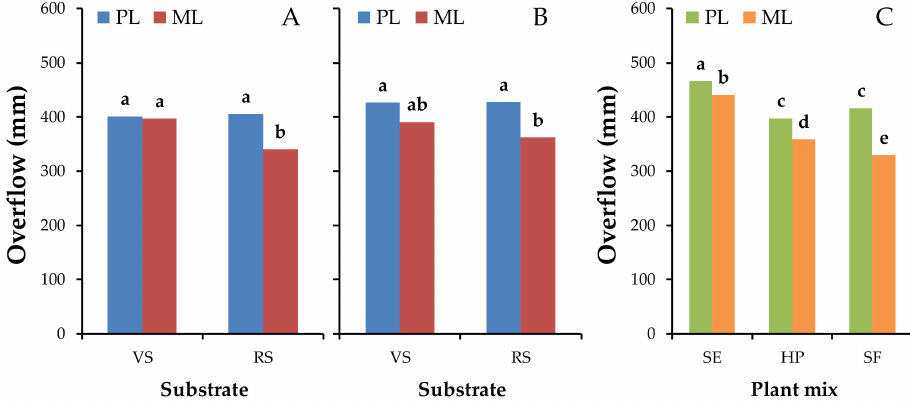
Figure 5. Interaction effect of substrate × drainage/storage layer in the first evaluated year ( A ), and sub- strate × drainage/storage layer ( B ) and plant mix × drainage/storage layer ( C ) in the second evaluated year on the yearly runoff volumes. Histogram values with different letters indicate significant differences according to Tukey’s HSD test ( p ≤ 0.05). SE = Sedum mix, HP = herbaceous perennial plants, SF = suffruticose, VS = volcanic substrate, RS = recycled crushed bricks substrate, PL = preformed plastic drainage/storage layer, and ML = mineral drainage/storage